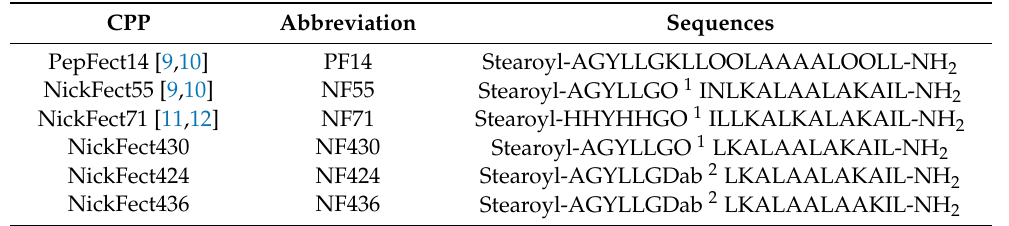
Table 1. Sequences of cell-penetrating peptides used for this